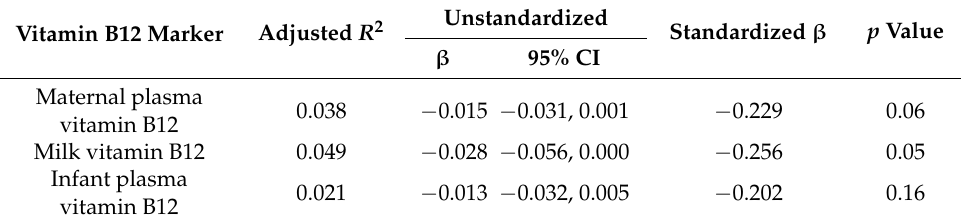
Table 3. Linear regression models of the association between infant age and plasma and milk vitamin B12 concentrations among the Cambodian sample.